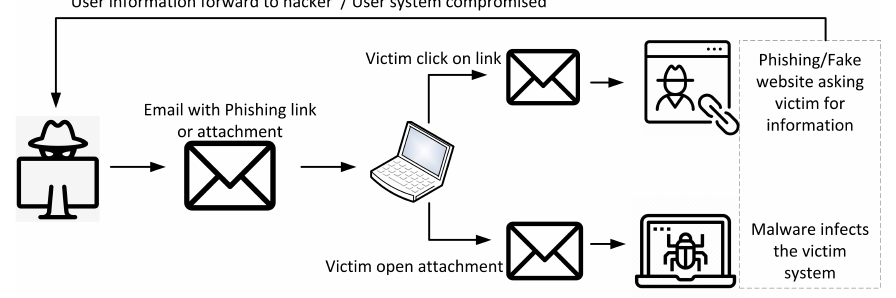
Figure 2. The common flow of phishing